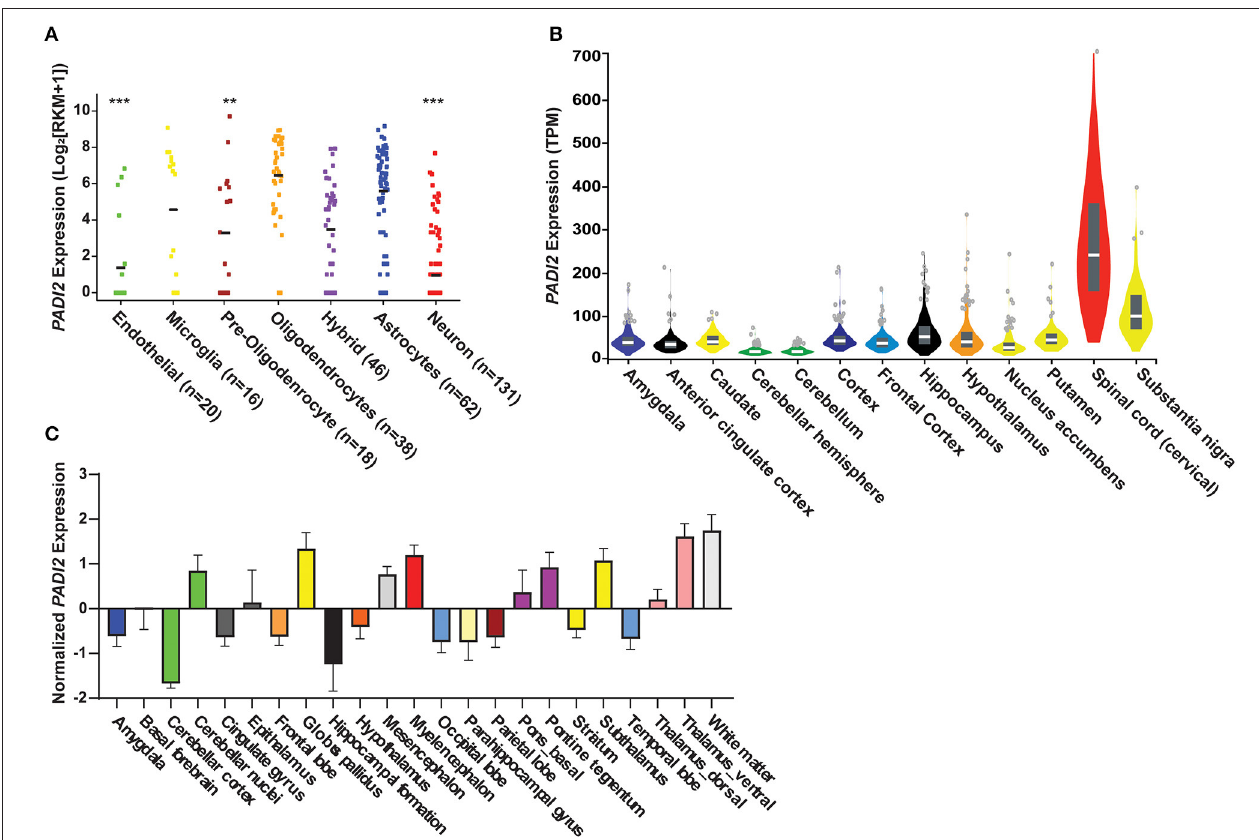
FIGURE 1 | PAD2 transcripts are detectable in glia in the human central nervous system. (A) in silico analyses of single cell RNA-sequencing data from the GEO human cortex show PADI2 expression in reads per kilobase of transcript per million (RPKM; y -axis) in various cell types ( x -axis) of the CNS. The number of cells analyzed in each group is provided after the region in paratheses. The mean RPKM of oligodendrocytes was compared to that to the mean of each other cell type in the dataset by ANOVA with Kruskal–Wallis test to corrected for multiple comparisons. **** p -value < 0.0001; ** p -value < 0.01. (B) PADI2 expression from bulk RNA sequencing of different CNS regions was downloaded from the GTEx database and gene expression in transcript per million (TPM) is plotted ( y -axis) for different brain regions and the spinal cord ( x -axis). Image is modified from (https://gtexportal.org/home/gene/PADI2). (C) Transcript expression of PADI2 in different regions of the brain measured by microarray was downloaded from The Allen Institute. Normalized PADI2 gene expression ( y -axis) is shown for multiple brain regions ( x